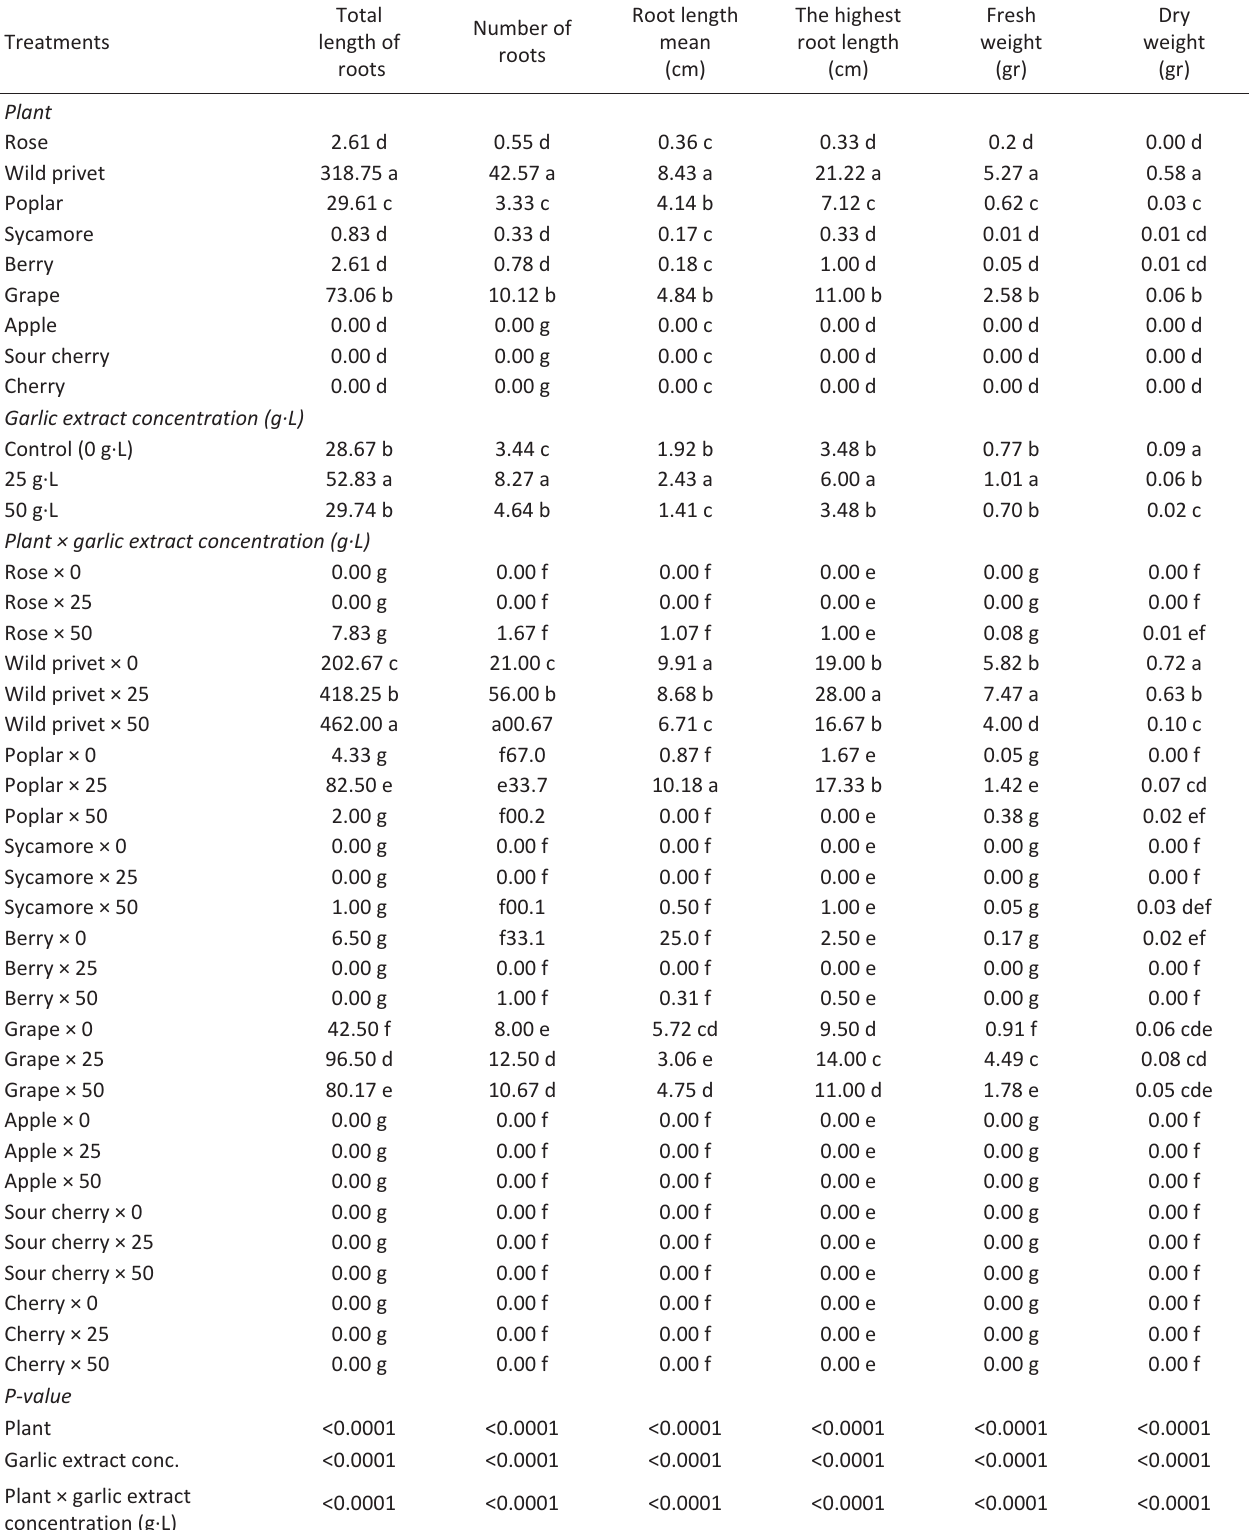
Mean values followed by the similar letters within a column are not significantly different from each other at P ≤0.05 (Duncan’s multiple range